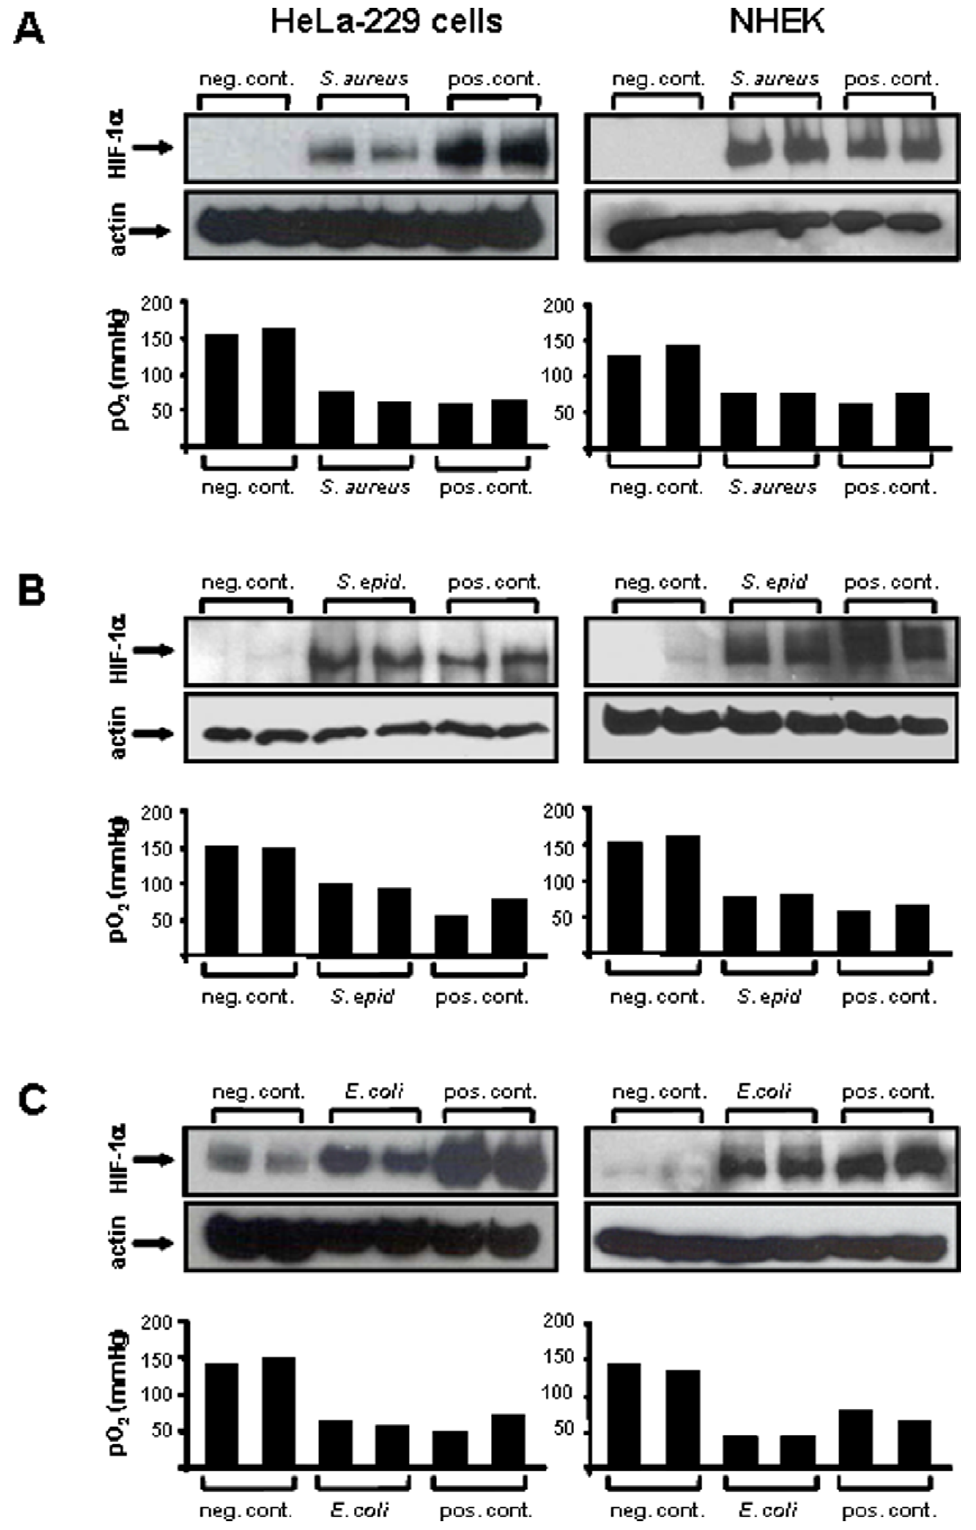
Figure 2. Oxygen-dependent HIF-1 activation in HeLa-229 cells and NHEKs (Normal Human Epidermal Keratinocytes) by bacterial and fungal pathogens. Four to six hours upon infection, HIF-1 activation was determined by Western blotting (loading control: actin). pO 2 levels were quantified in the medium of control and infected cells (A: S. aureus ATCC 33592, MOI 20, infection time: six hours; B: S. epidermidis ATCC 12228, MOI 20, infection time: six hours; C: E. coli ATCC 25992, MOI 10, infection time: four hours). Negative control: uninfected cells, positive control: hypoxia or DFO (200 m mol/L).